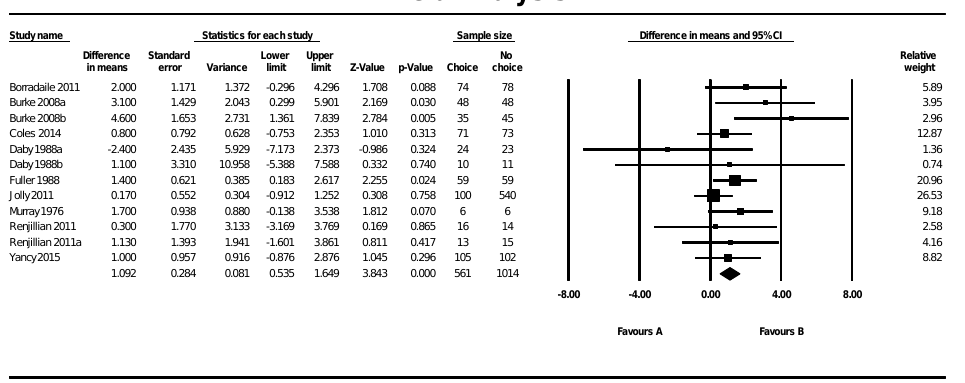
Figure 2. Forest Plot from fixed meta-analysis for weight in Kg. A = Choice, B= No-Choice.